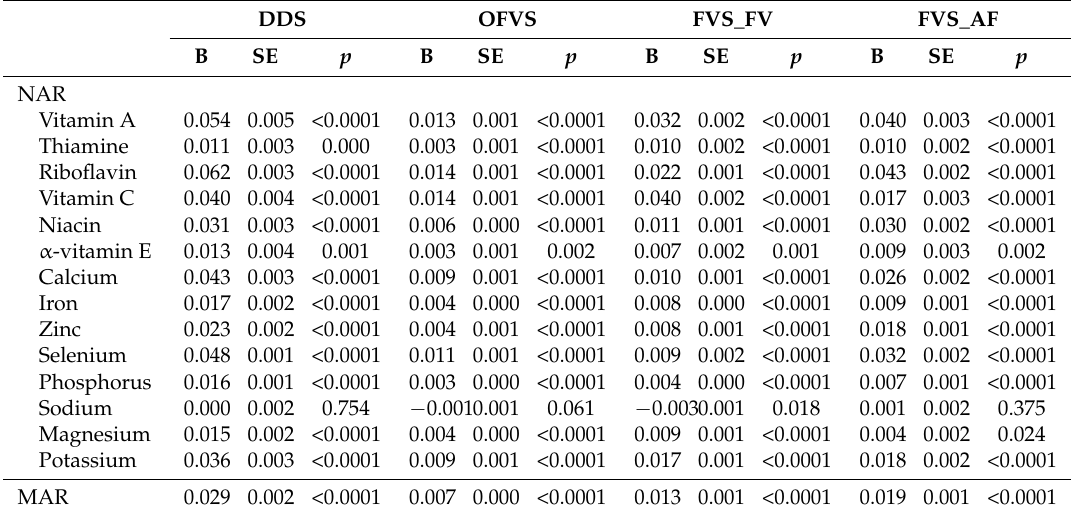
Table 3. Association of DDS and FVS with NARs and MAR using linear regression model § ( n = 2012). DDS OFVS FVS_FV